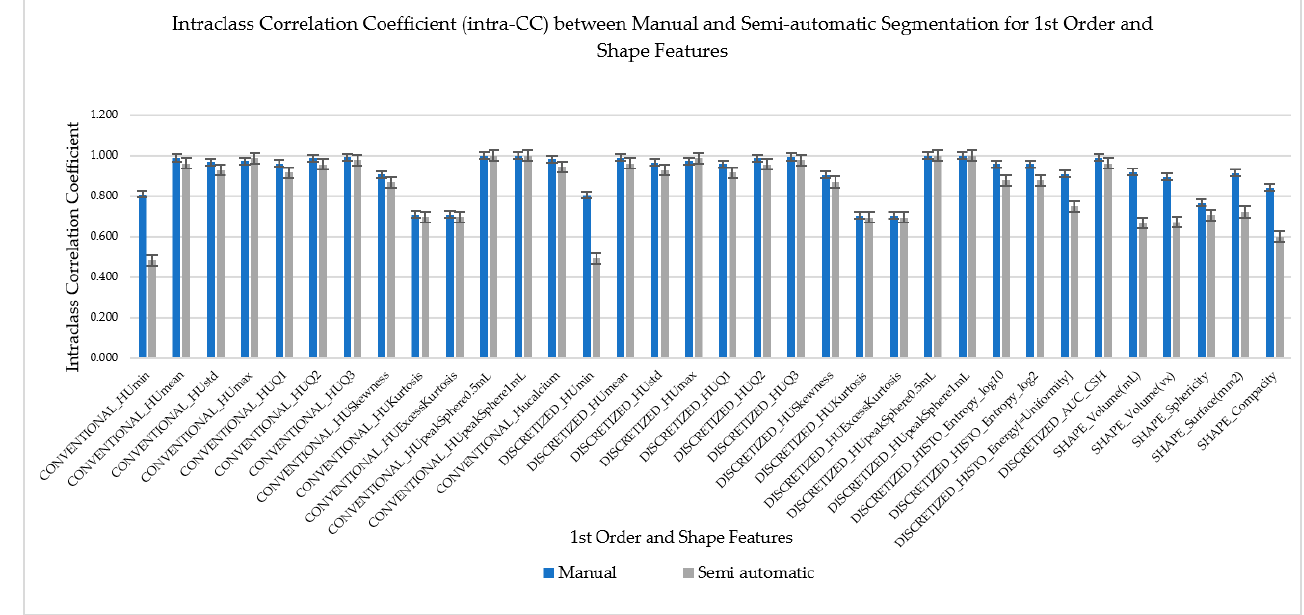
Figure 7. Intraclass Correlation Coefficient (intra-CC) between manual and semi-automatic segmen- tation for 1st order Features including the Shape Features to compare its repeatability.